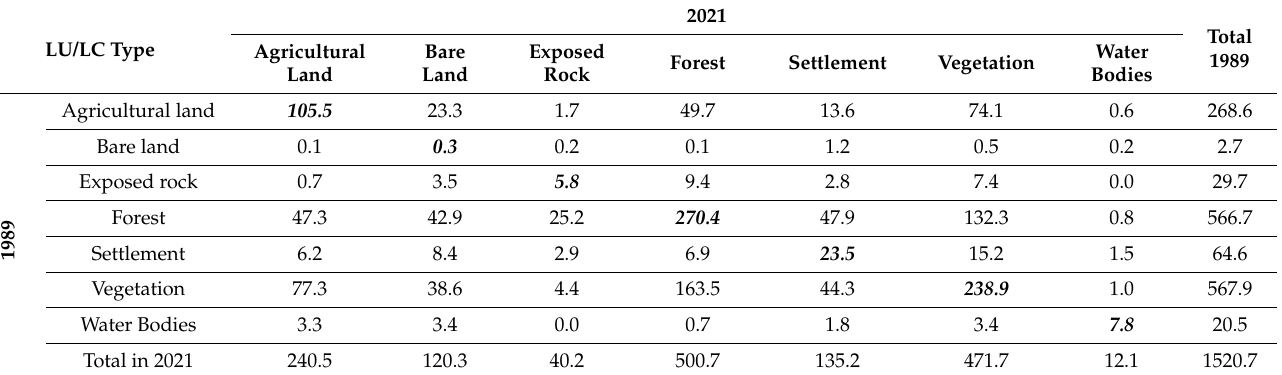
Table 7. LU/LC change matrix of MORB from 1989 to 2021 (km 2 ).